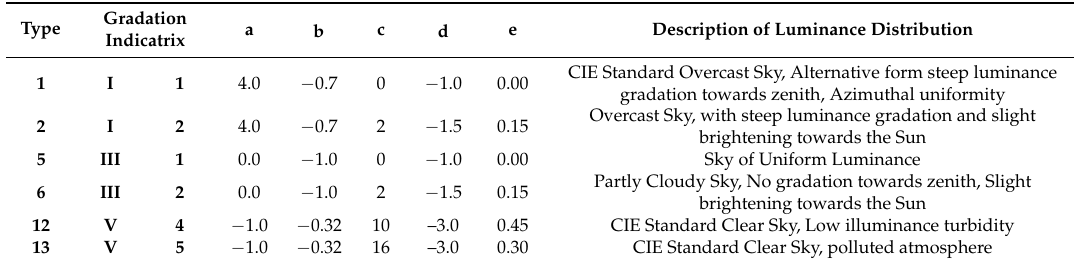
Table 1. CIE standard sky model’s parameters.